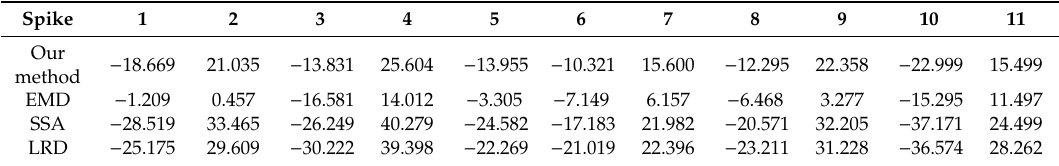
Table 3. The di ff erences on the magnitudes of the spikes at these 11 points before and after applying the above four despiked